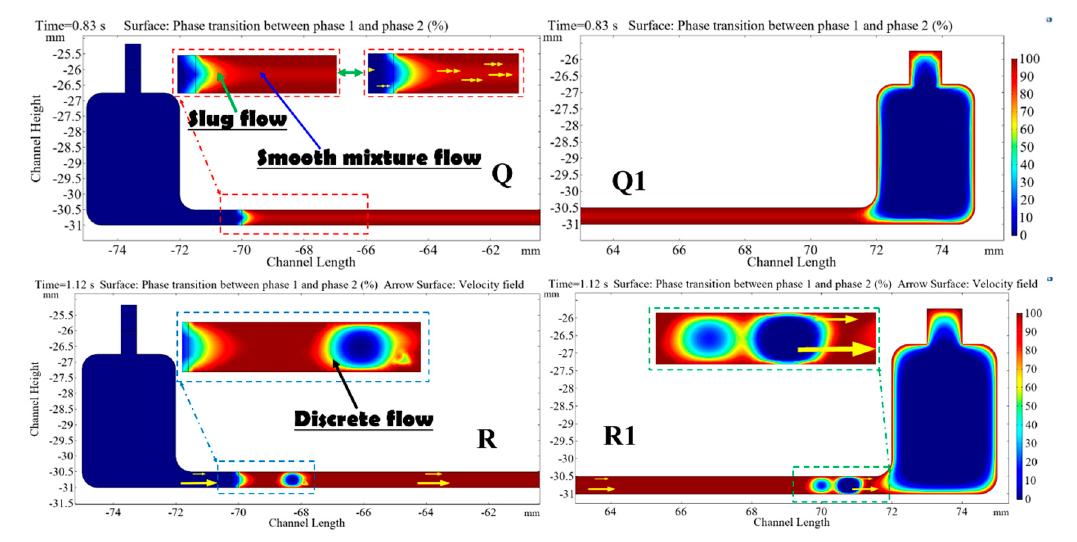
Figure 11. The phase change in the heat transfer model at constant walls temperature: [Q-R] Channel inlet area, [Q1-R1] Channel outlet area.